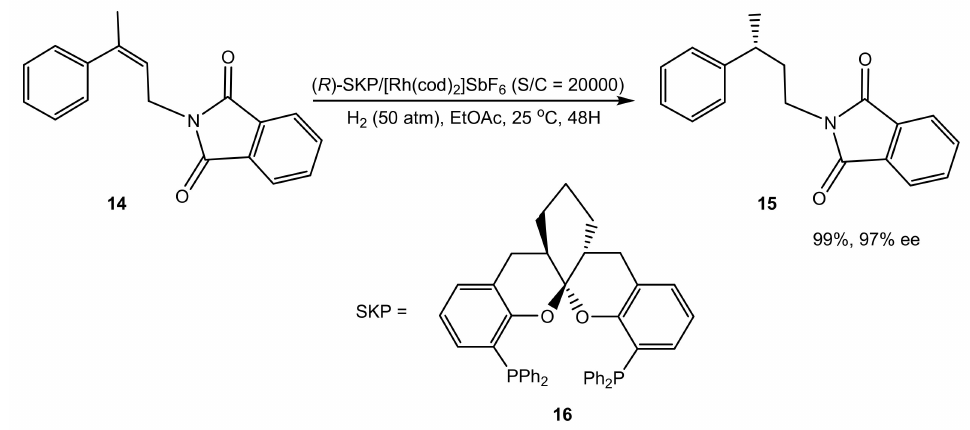
Scheme 5. Multigram scale asymmetric hydrogenation with the Rh–SKP complex.